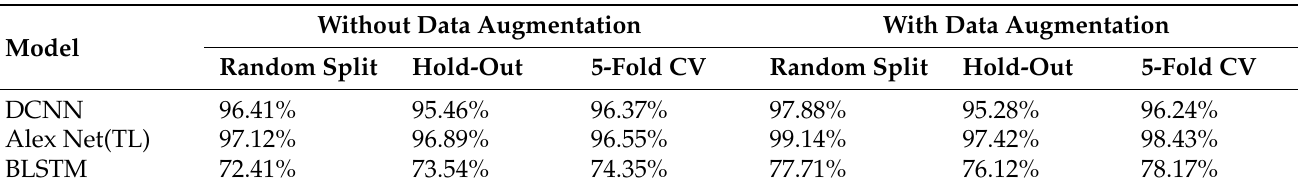
Table 8. Arabic alphabet pronunciation classification with and without data augmentation. Without Data Augmentation With Data Augmentation Model